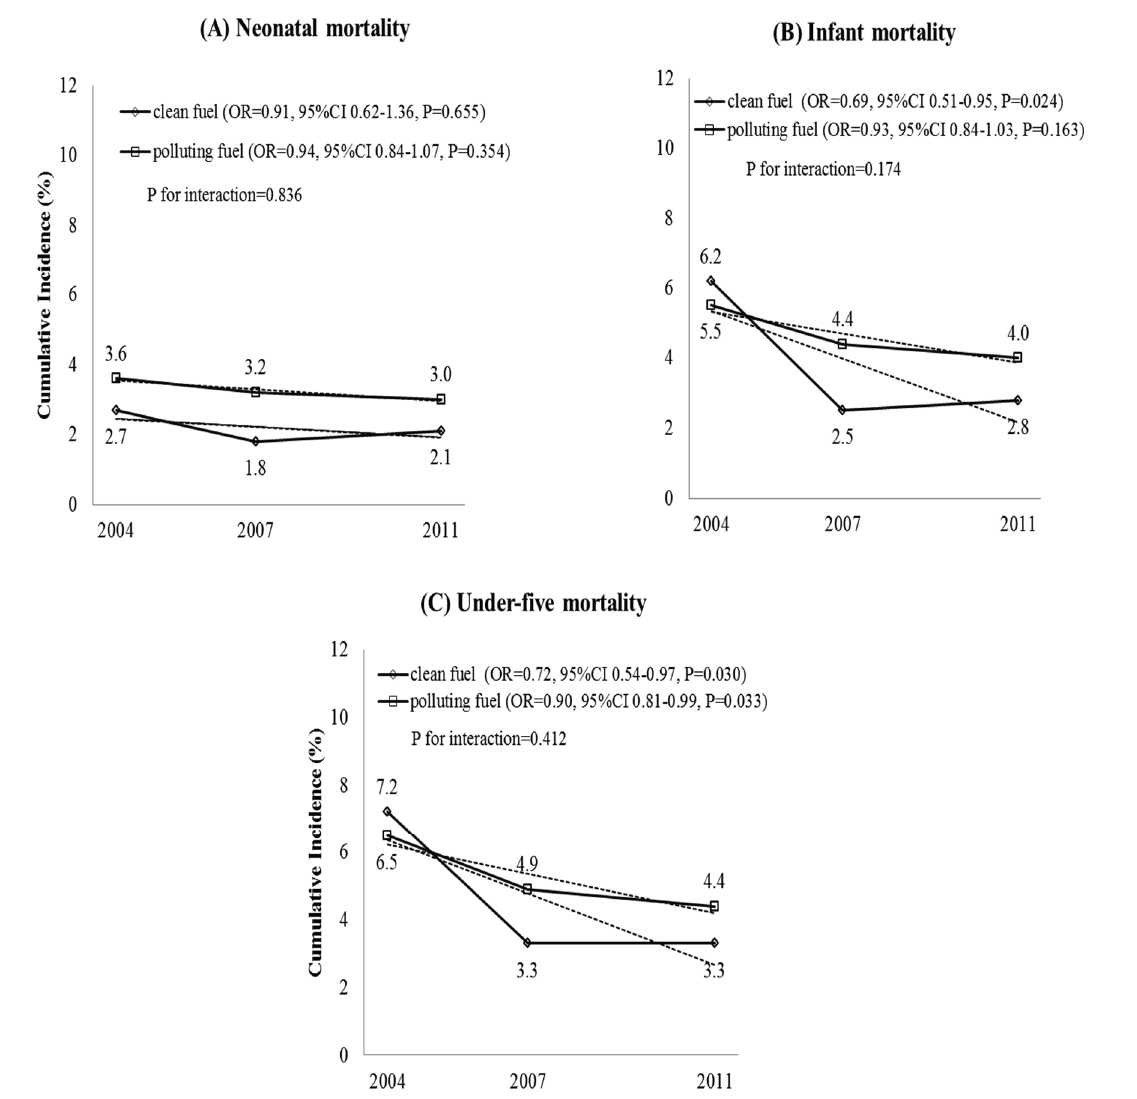
Figure 1. Under-five mortality trend with exposure to cooking fuel in Bangladesh (2004–2011). P for interaction based on likelihood ratio test of “period” by “exposure to polluting fuels”. Odds ratios (OR) for linear trend ( i.e. the period effects) for each exposure group (clean or polluting fuel) were adjusted for wealth index, place of residence, mother’s age, mother’s education, mother’s working status, breastfeeding status and household wall